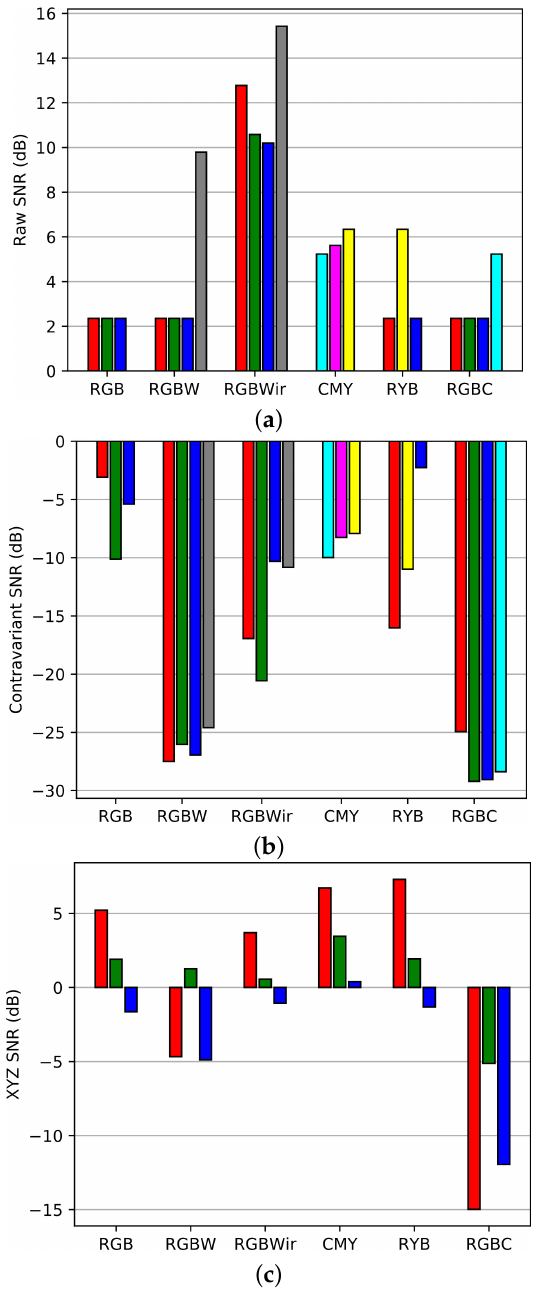
Figure 22. SNR results for dim light conditions. ( a ) SNR raw, ( b ) contravariant SNR, ( c ) color